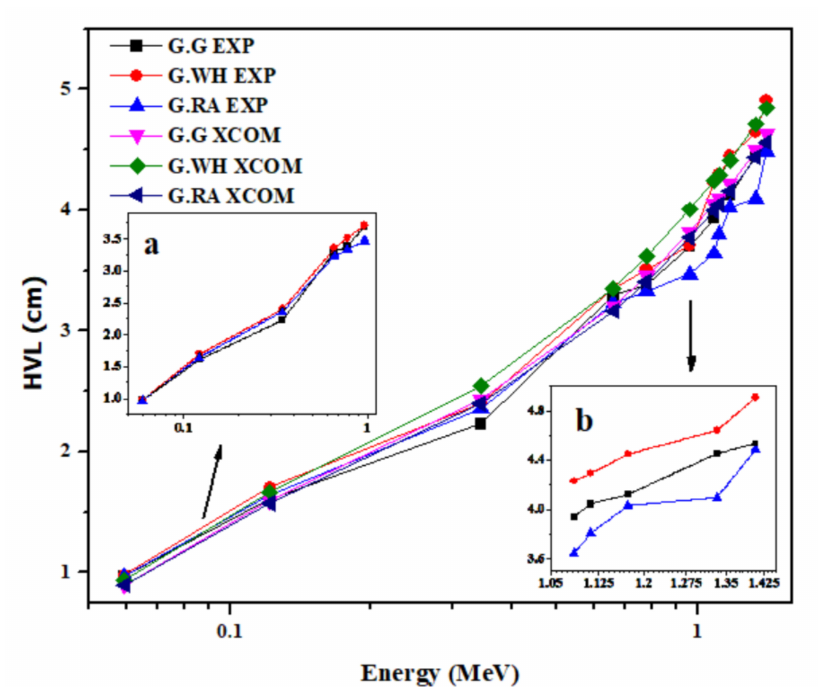
Figure 3. Variation of the experimental and theoretical values of half-value layer (HVL) with photon energy for the granite samples in the energy range 0.015 to 15 MeV. Insets ( a , b ) to the figure show the variation of the experimentally obtained HVL in the low and high energy ranges, respectively.